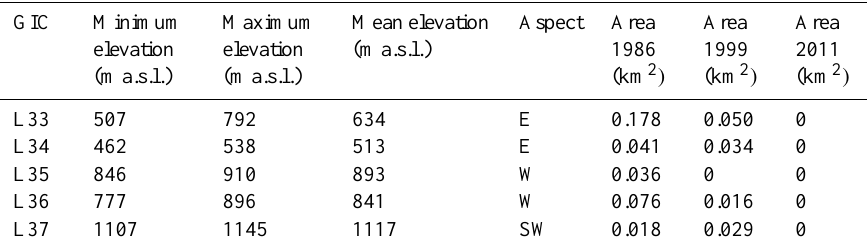
Table 4. Characteristics of land-terminating GIC L33–L37 in the Ammassalik region, which have melted away during the period 1986–2011 (see Fig. 1 for location of the doomed glaciers). Mean elevation Aspect Area Maximum GIC Minimum (ma.s.l.) 1986 elevation elevation (km 2 (ma.s.l.) (ma.s.l.)